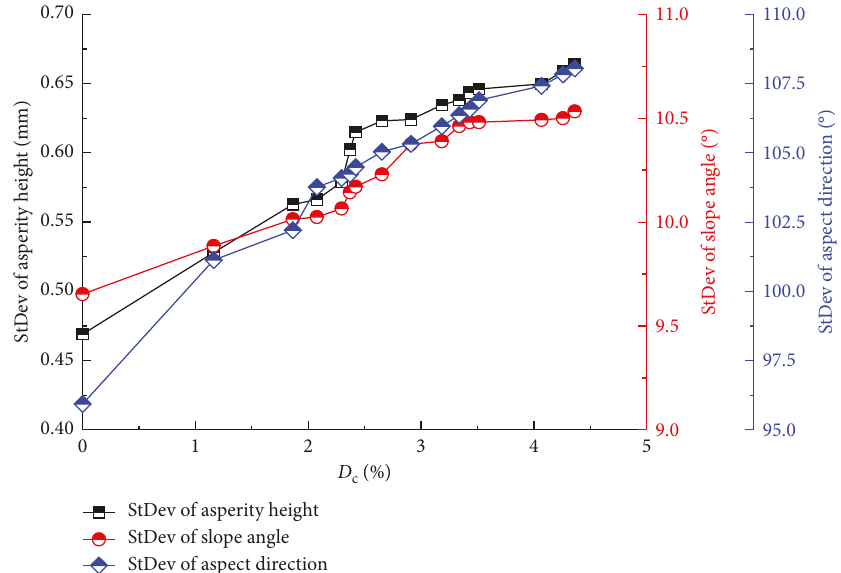
� 0, 1.16, 1.95, 3.02, 3.62, c